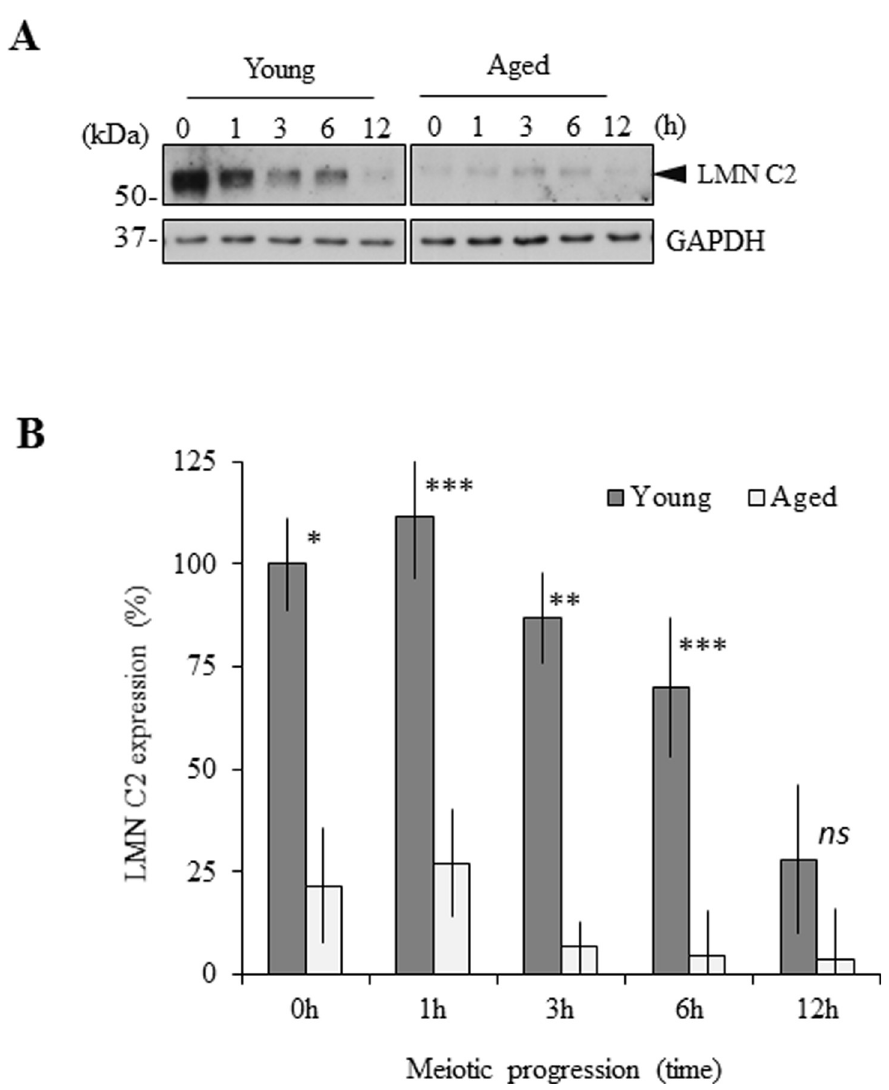
Fig 5. Expression of LMN C2 significantly differs between oocytes from young and aged females. A) Immunoblot detection of LMN C2 and GAPDH protein expression in the oocytes from young (2 months) and aged (12 months) females during meiotic progression. Representative images from at least three independent experiments are shown. Black arrowhead depicts endogenous LMN C2 protein. B) Quantification of LMN C2 expression in the oocytes from young and aged females during meiotic progression. Presented as mean, ± SD, � p < 0.05; �� p < 0.01; ��� p < 0.001; ns - nonsignificant, t-test. GAPDH was used as an endogenous loading control. Representative images from at least three independent experiments are